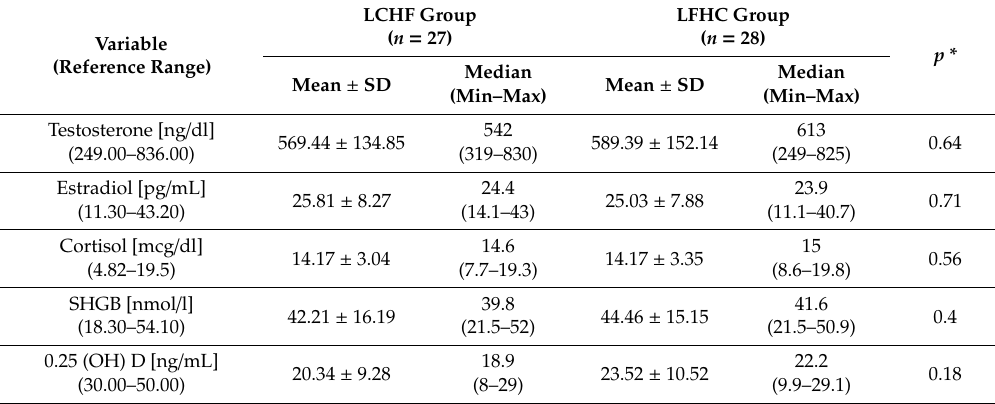
Table 4. The mean and median of the levels of hormones and Sex Hormone Binding Globulin (SHGB) in both groups at the early stage of the